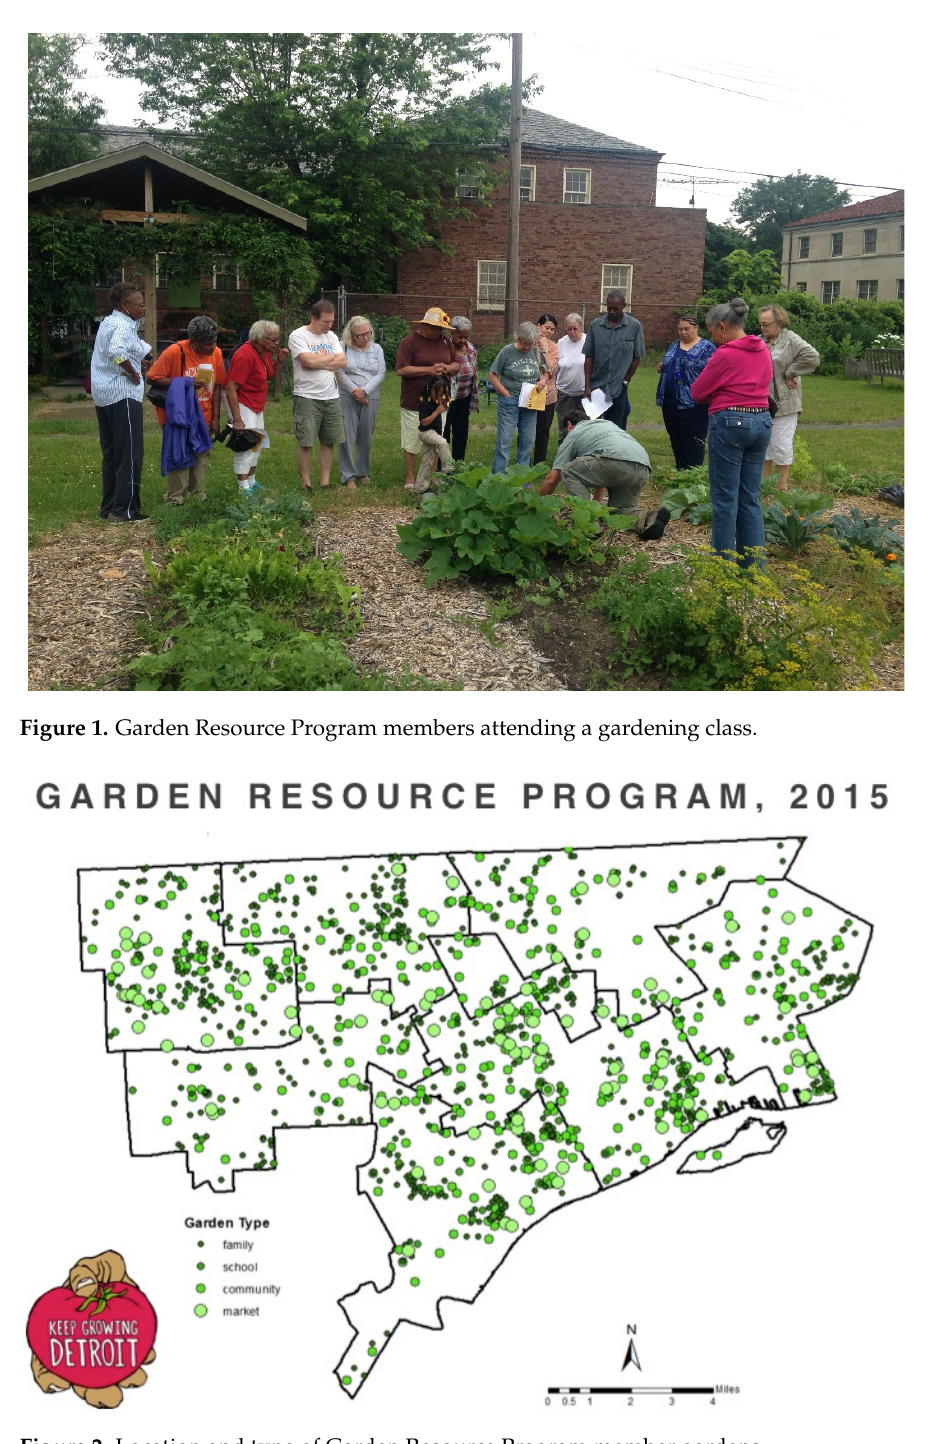
Figure 2. Location and type of Garden Resource Program member gardens